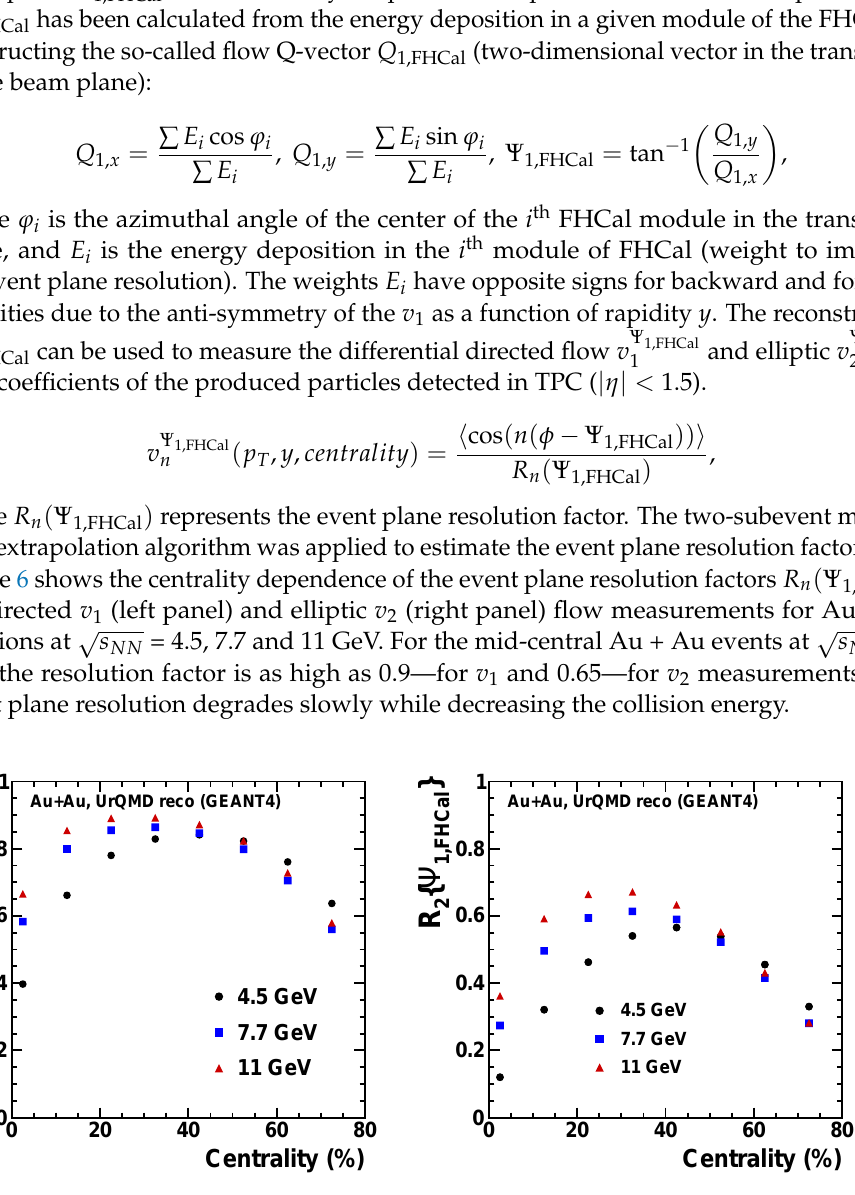
√ s NN = 4.5, 7.7 and 11 GeV. √ s NN = 7.7 GeV.